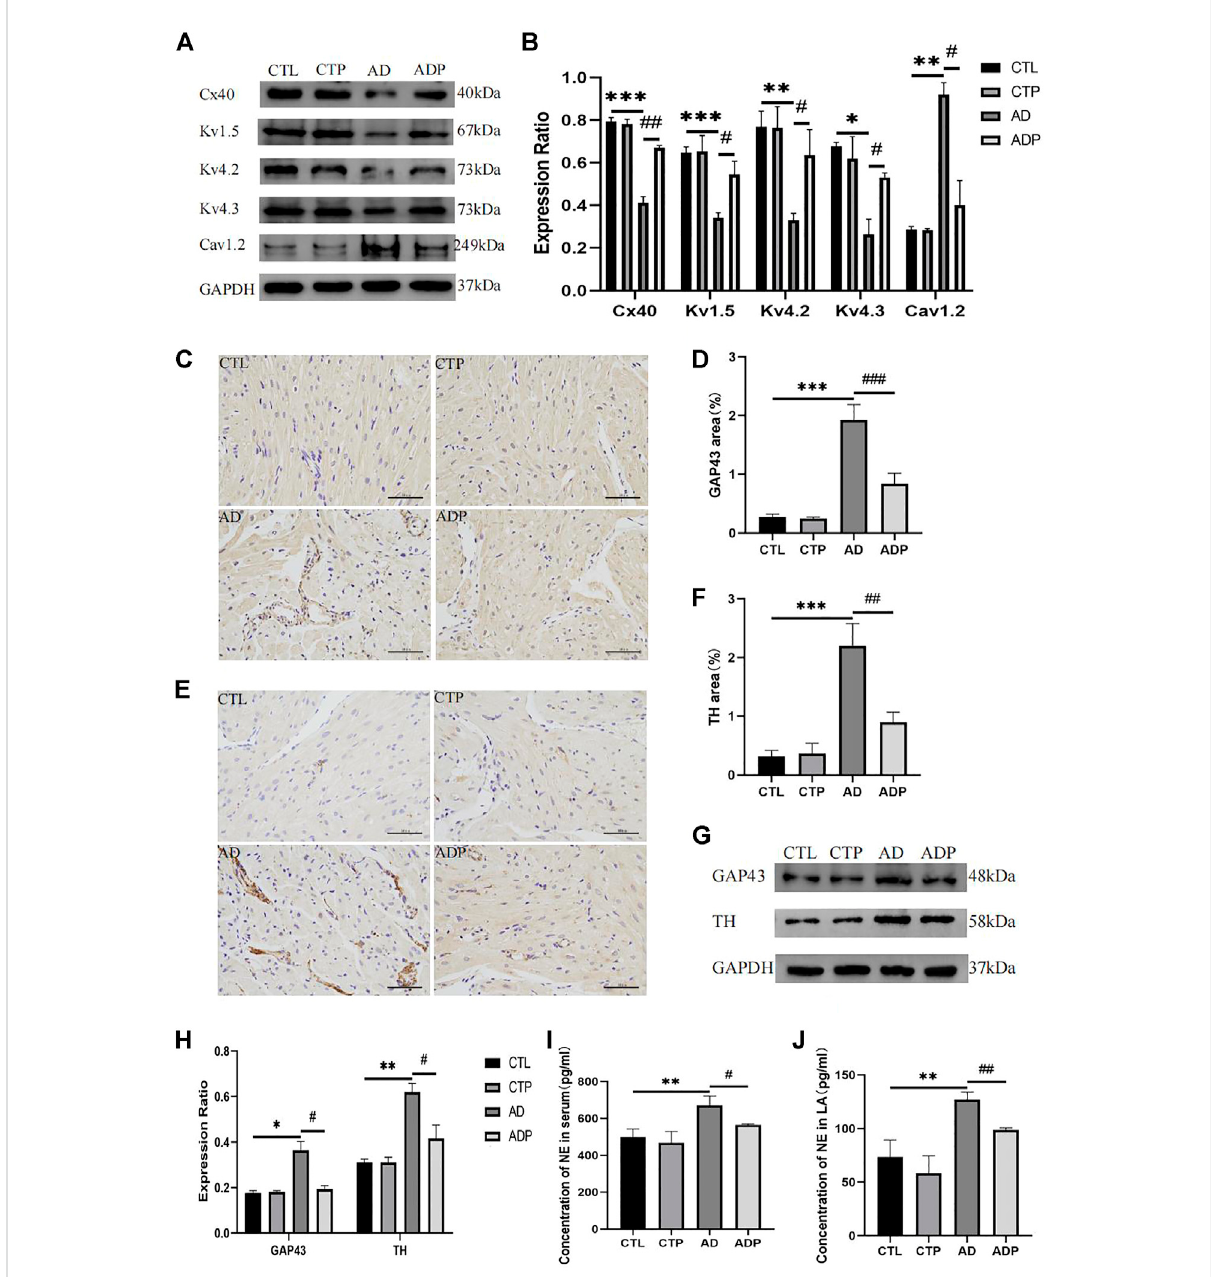
FIGURE 6 Ion channels remodeling, Cx40 expression, and autonomic remodeling. (A,B) Immunoblotting and quantitative analysis of Cx40, Kv1.5, Kv4.2, Kv4.3 and Cav1.2, n = 3 per group (C ,D) Typical images of GAP43 immunohistochemical staining and percentage of the GAP43 area, n = 5 per group. (E,F) Typical images of TH immunohistochemical staining and percentage of the TH area, n = 5 per group. (G,H) Immunoblotting and quantitative analysis of GAP43 and TH, n = 3 per grou4.3p. (I,J) Concentration of NE in serum and LA, n = 5 per group. * p < 0.05, ** p < 0.01, *** p < 0.001 vs. CTL; # p < 0.05, ## p < 0.01, ### p < 0.001 vs.